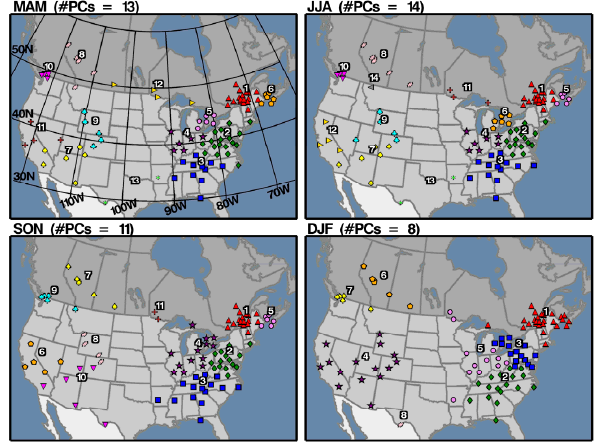
Fig. 2. Average three-day backward air parcel trajectories for each ozone measurement site for the period 1997–2006 for different sea-